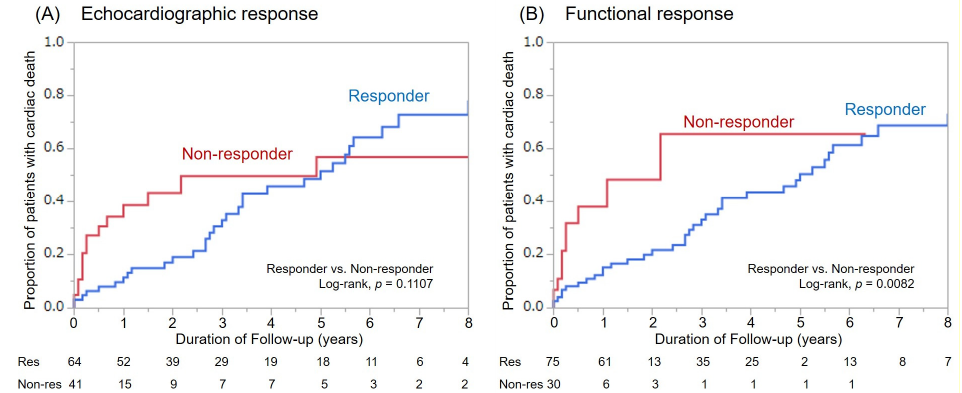
Figure 4. Cumulative number of cardiac deaths among responders and non-responders based on both re-sponse definitions. ( A ): Echocardiographic response, ( B ): Functional response.